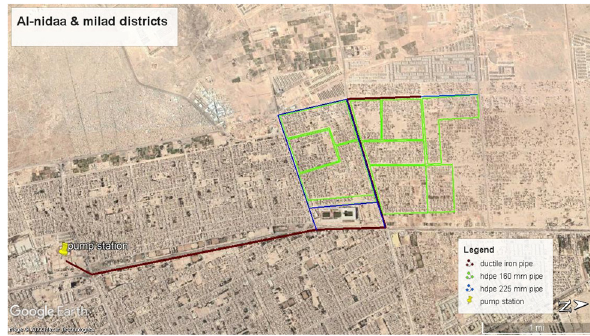
Figure 4: The fi eld apparatus used for the pressure head